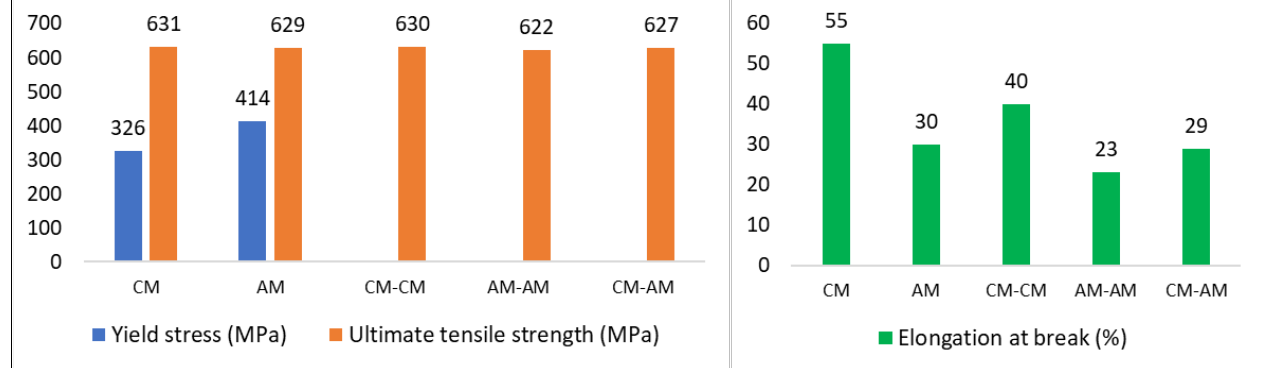
Figure 13. Tensile test results of reference and welded samples.